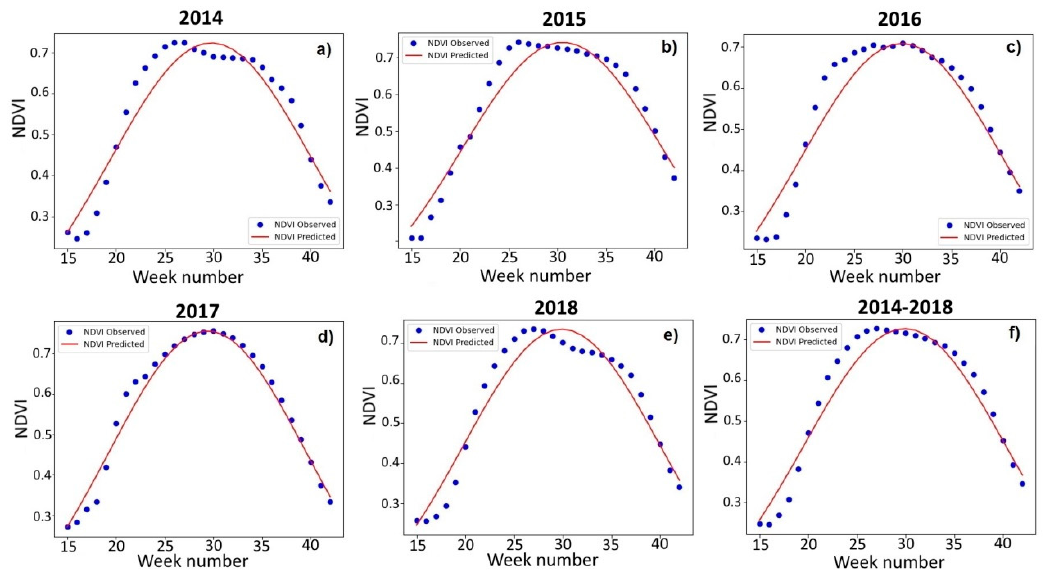
Figure 6. Observed and approximated weekly NDVI composites (15th–42nd calendar weeks) for the arable land in the Khabarovsk District in ( a ) 2014; ( b ) 2015; ( c ) 2016; ( d ) 2017; ( e ) 2018; ( f ) 2014–2018 (average).